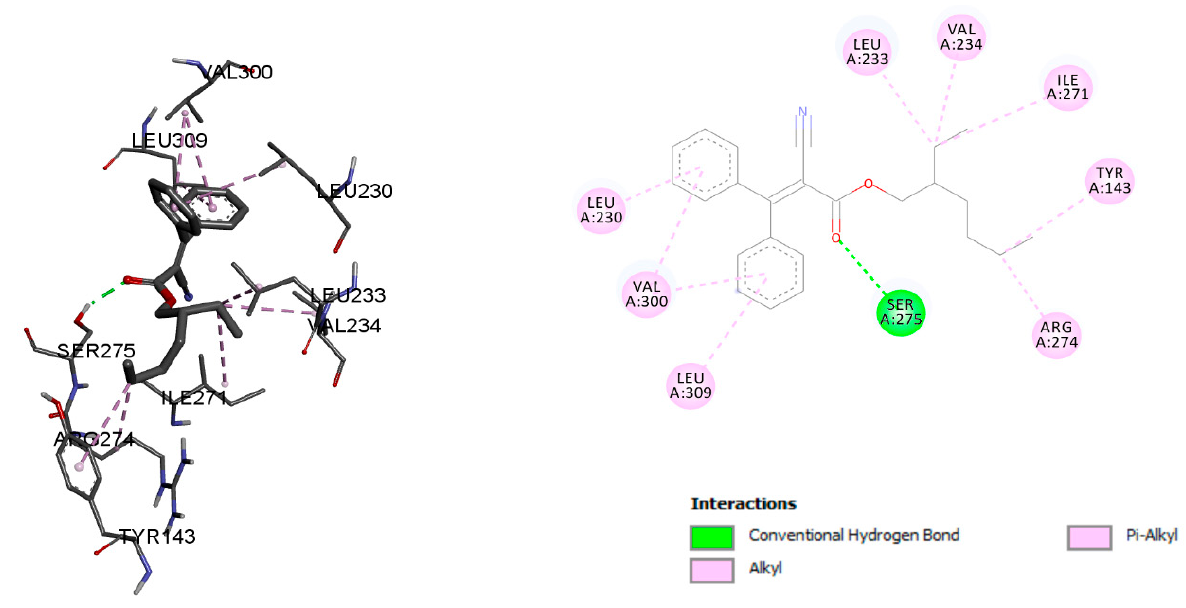
Figure 4. Octocrylene molecular interaction with the vitamin D receptor.